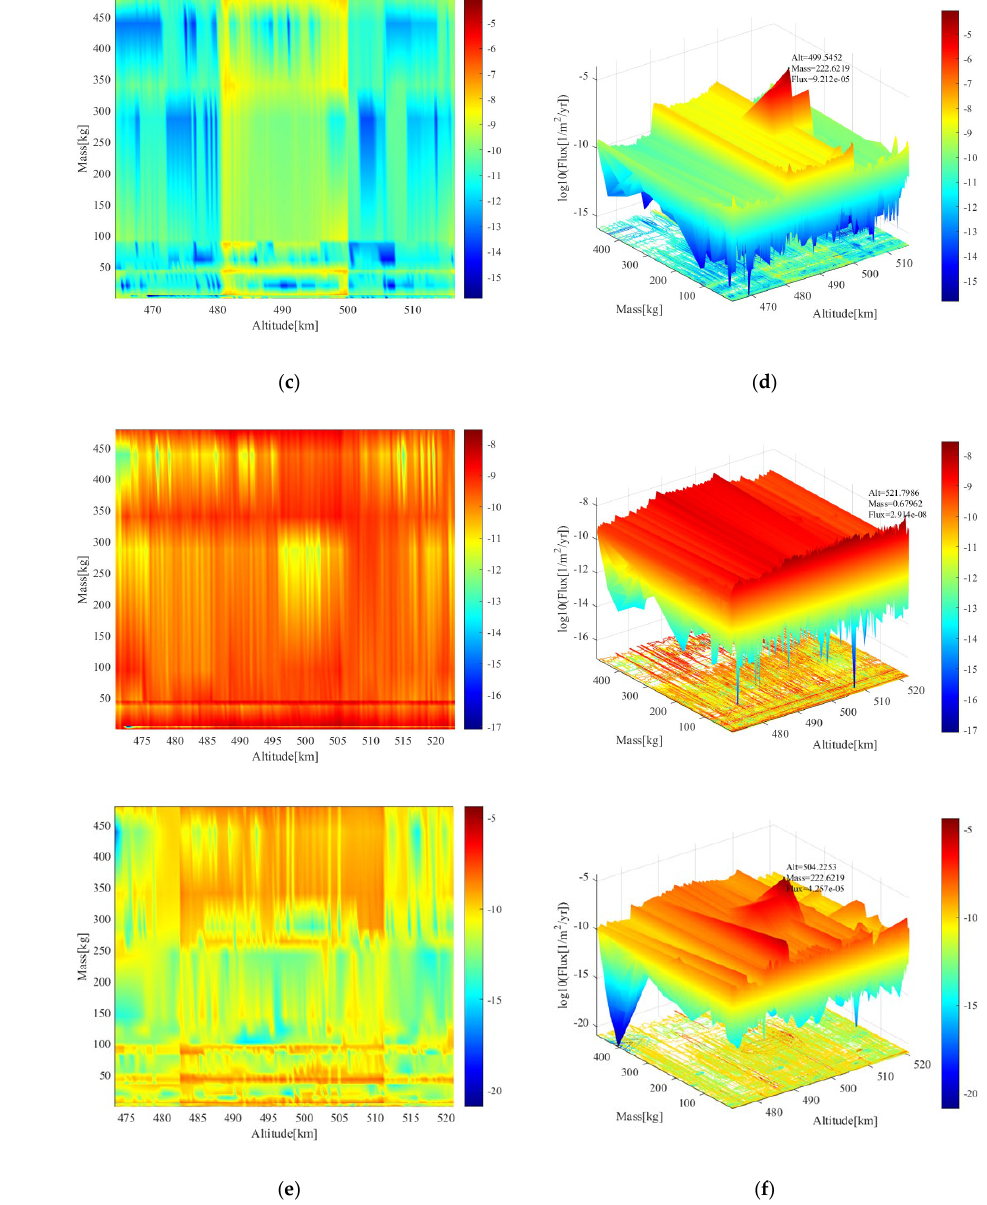
Figure 6. Object height fluxes and object size fluxes. ( a , b ) Before and after Alt-Mass fluxes of GAOFEN satellites; ( c , d ) Before and after Alt- Mass fluxes of CORVUS BC5 satellites; ( e , f ) Before and after Alt- Mass fluxes of YAOGAN-35C satellites.